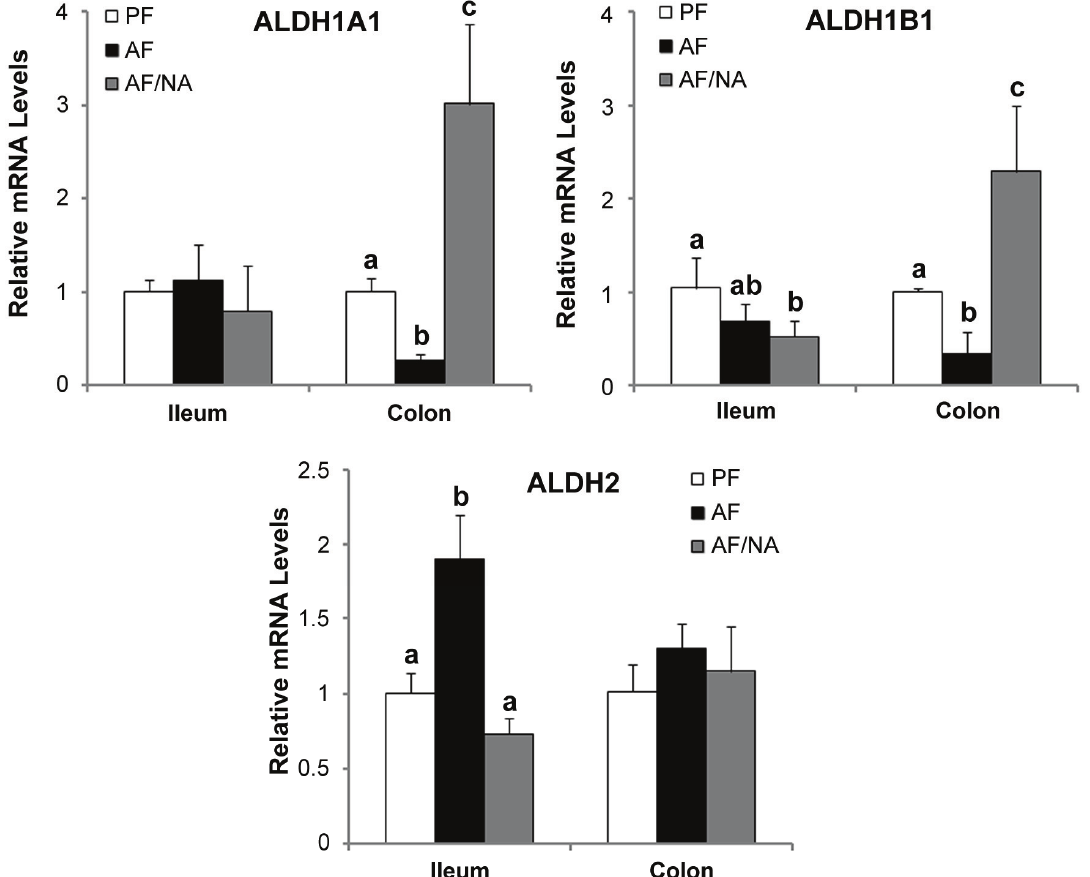
Figure 7. Expression of intestinal epithelial ALDH genes in rats fed alcohol with or without nicotinic acid supplementation for 8 weeks. Gene expression was assessed by qPCR assay of the mRNA levels. Results are means ± SD ( n = 6–8). Significant differences ( p < 0.05, ANOVA) are identified by different letters. PF: pair-fed; AF: alcohol-fed; AF/NA: alcohol-fed with nicotinic acid